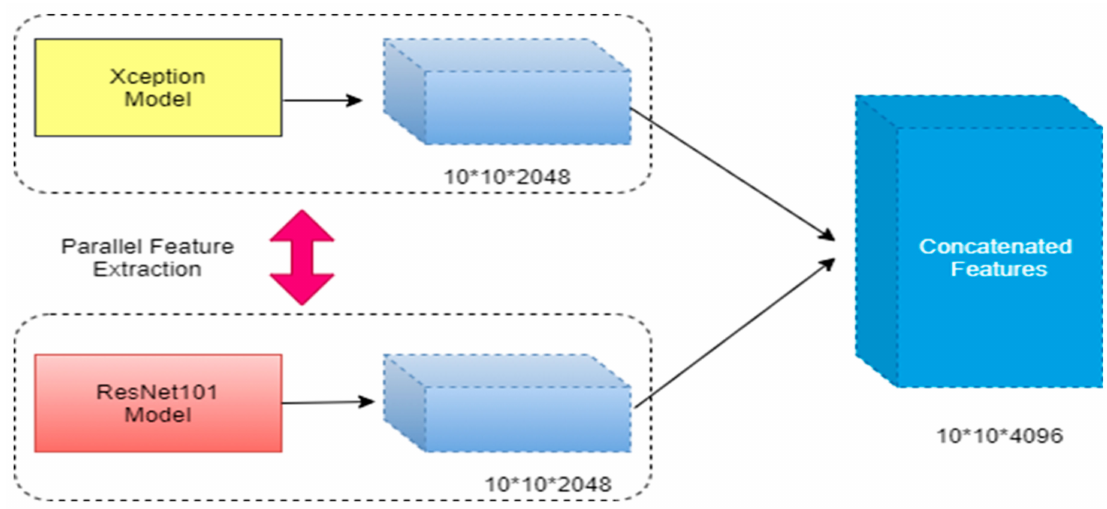
Figure 5. Concatenated network